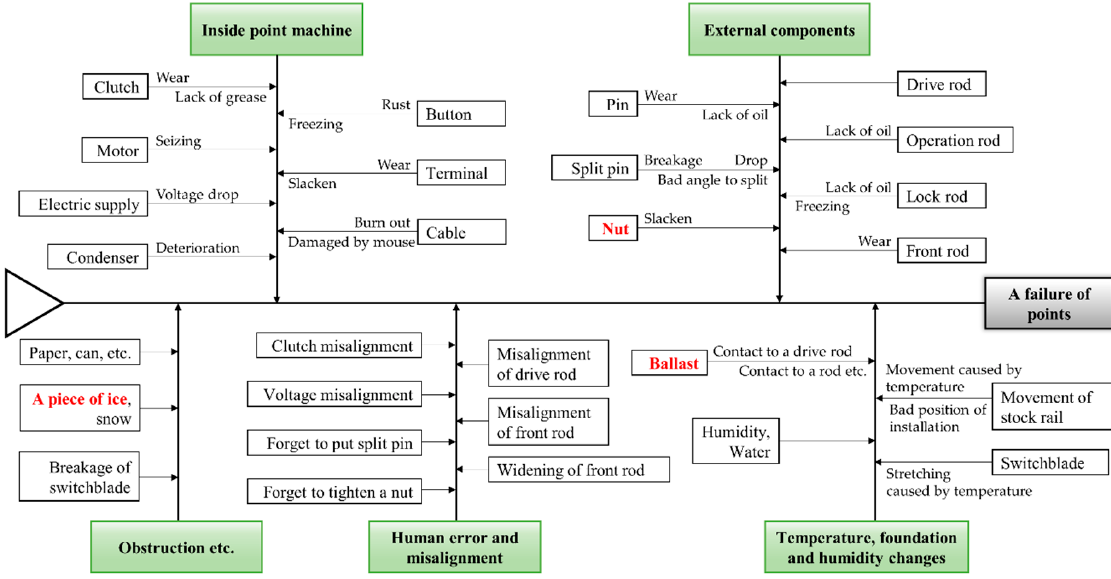
Figure 8. Fishbone diagram of faults for railway point machines [7].